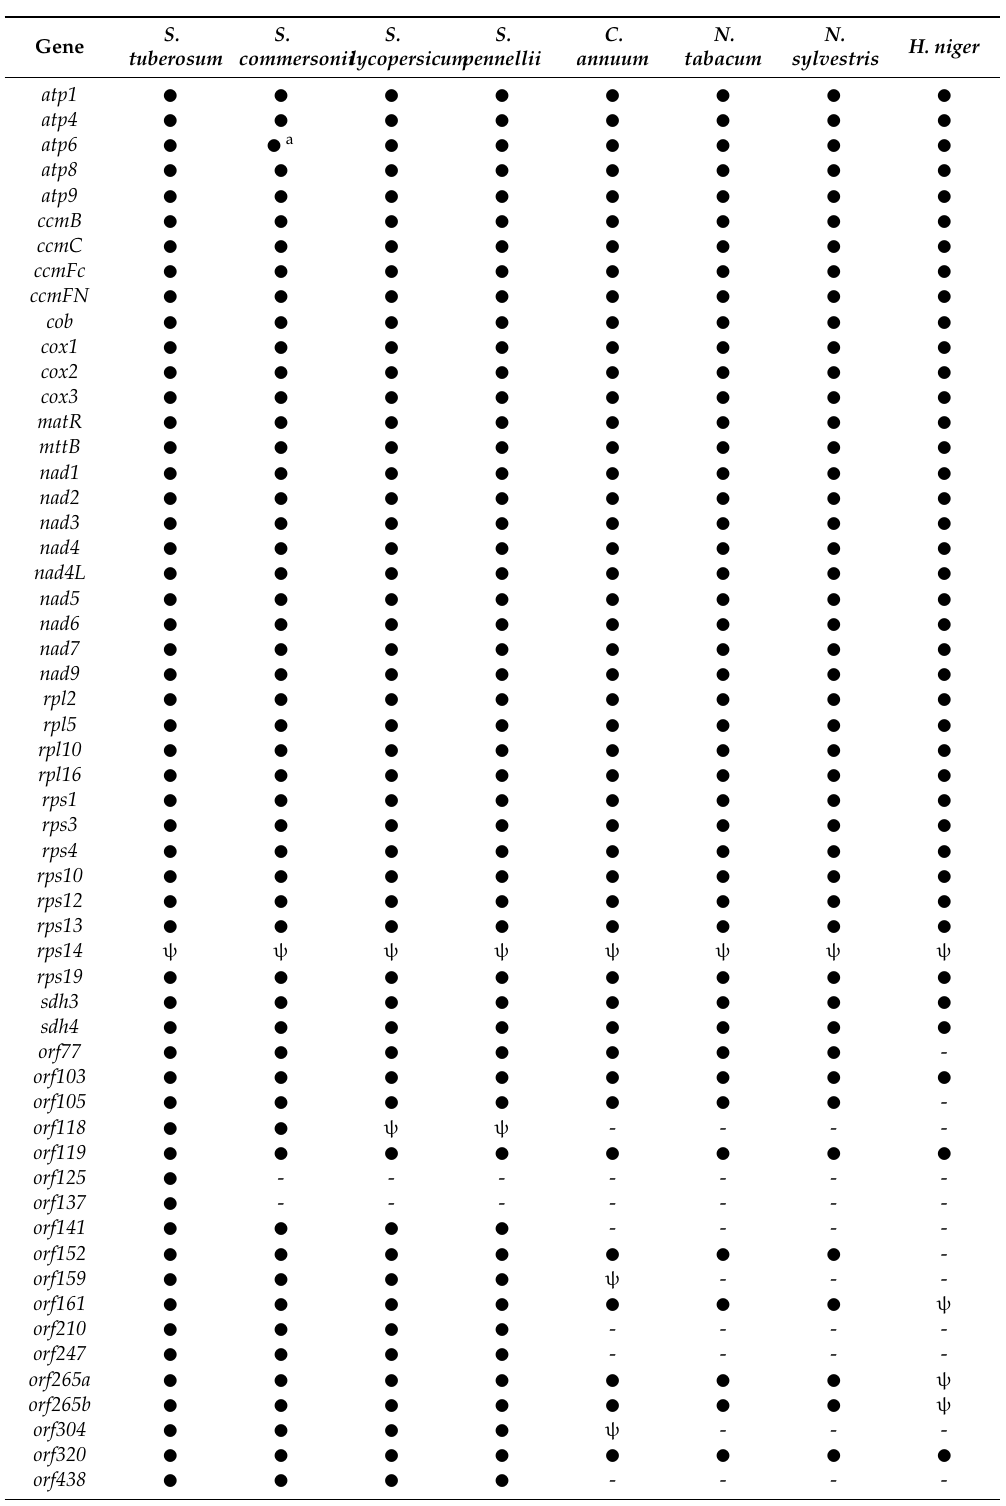
Table 4. Mitochondrial genes encoding proteins and transcribed open reading frames ( orfs ) among Solanaceae species available in GenBank. The symbol (cid:8) indicates the presence of the gene; ψ , a pseudogene; -, gene